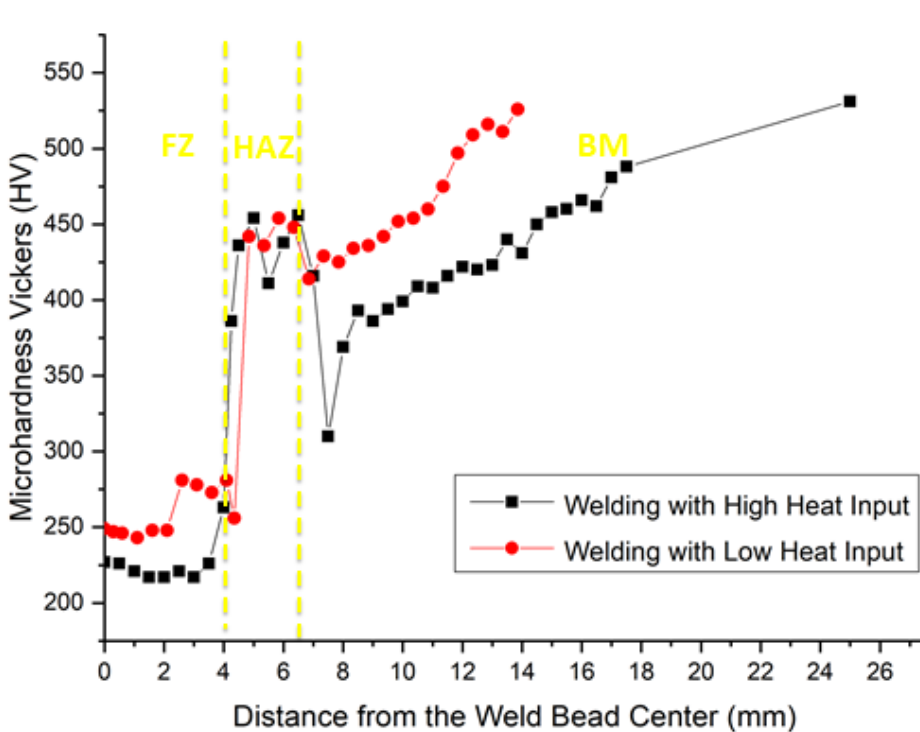
Figure 12. Graphical profile of microhardness measurements along the transversal section of the welded HHA steel for both heat input